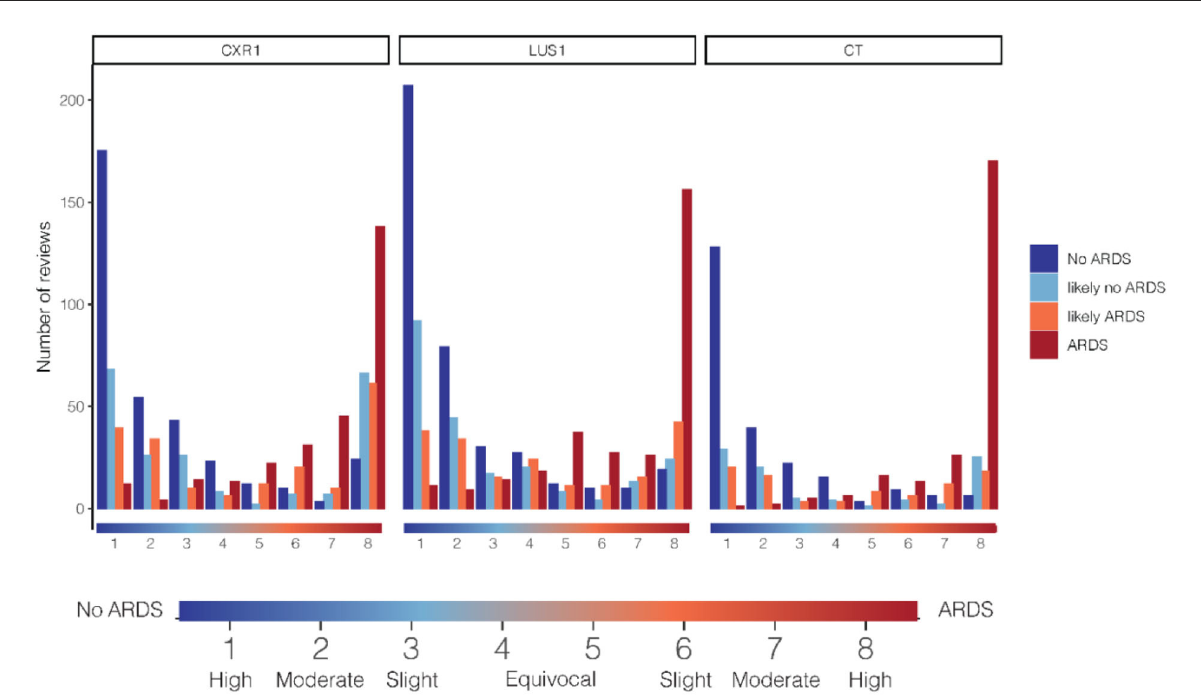
FIGURE4 Relationship between cumulative counts per confidence grade and ARDS category in the diagnosis of ARDS. On the x-axis, the confidence score on the 8-grade confidence scale. The confidence on the 8-grade scale corresponds to the confidence of the ARDS diagnosis, ranging from high confidence no ARDS (grade 1) to high confidence ARDS on both extremes (grade 8), see indicator below graph. Cumulative review counts: CXR1: 1,025, LUS1: 1,104, CT: 643. ARDS, acute respiratory distress syndrome; CXR, chest x-ray; LUS, lung